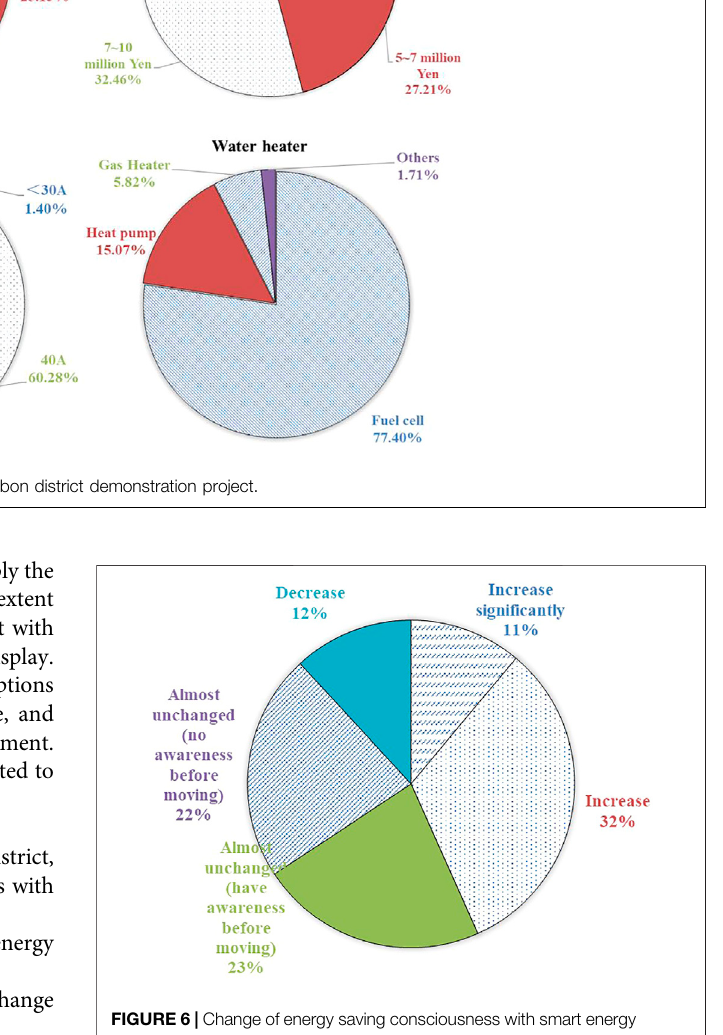
FIGURE 6 | Change of energy saving consciousness with smart energy use since movement into the